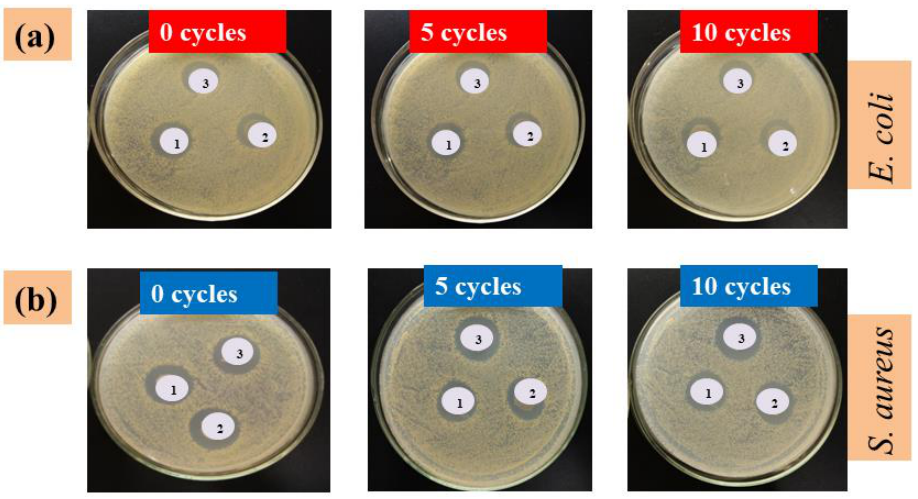
Figure 8. Inhibition zone photographs of YCF, RCF, and BCF before (0 cycles) and after 5 and 10 washing cycles against bacteria : ( a ) E. coli ; and ( b ) S. aureus .